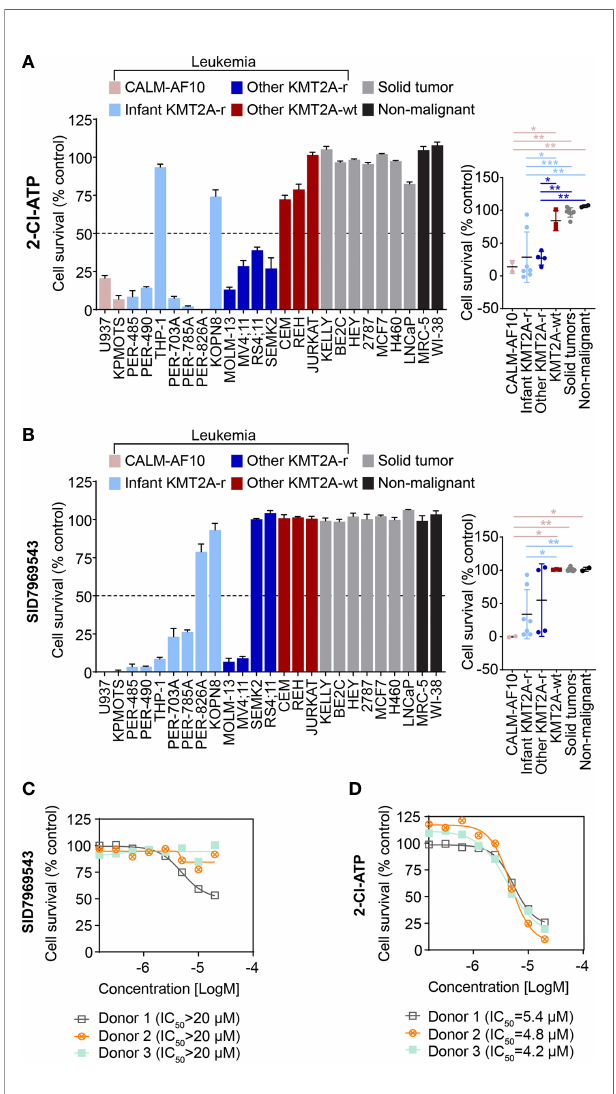
FIGURE 2 | The adenosine analog 2-Cl-ATP and the NR5A1 inhibitor SID7969543 display selective cytotoxicity against a subset of KMT2A-r leukemia cell lines. The percentage viability of a 25-cell line panel after treatment with 10 µM 2-Cl-ATP (A) or SID7969543 (B) in a 72-hour resazurin-based cytotoxicity assay is represented in a bar chart (left). The panel on the right depicts the comparison of viabilities of cell lines (mean ± SE) grouped based on subtype: CALM-AF10 translocated, infant KMT2A-r, other KMT2A-r, KMT2A-wt, solid tumor and non-malignant cell lines. Details